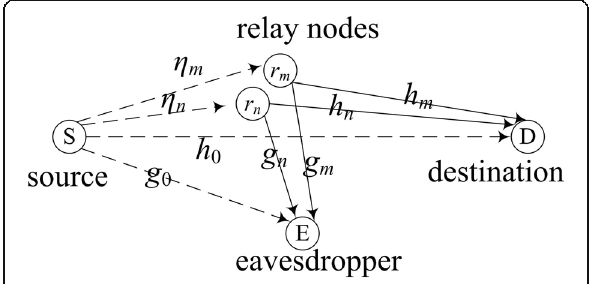
Fig. 1 The system model for cooperative transmission with terminals S i transmitting information to destination D